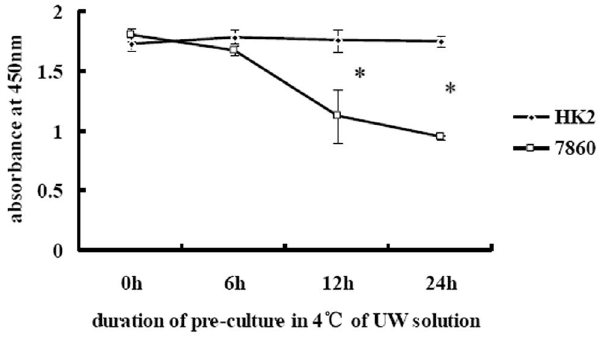
Figure 3. Proliferation of HK-2 and 7860 cells after cold-culture in UW solution and recovery in normal conditions. Cells were cold-cultured in UW solution for the indicated length of time and harvested. Harvested cells were plated onto 96-well plates at 3000 cells per well in complete medium and allowed to grow for 20 h in a 37 u C, 5% CO